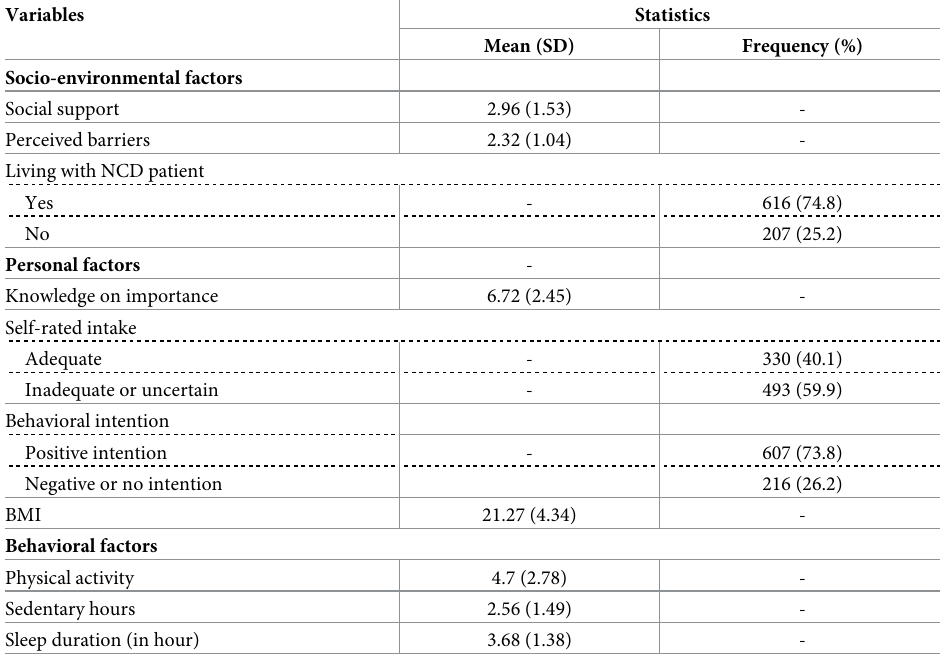
Table 3. Statistics of socio-environmental, personal, and behavioral